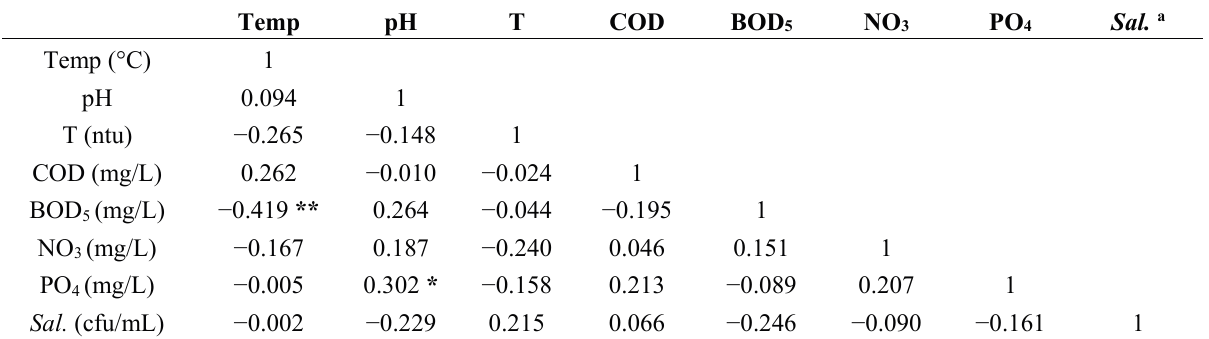
Table 5. Correlation matrices of physicochemical parameters at the